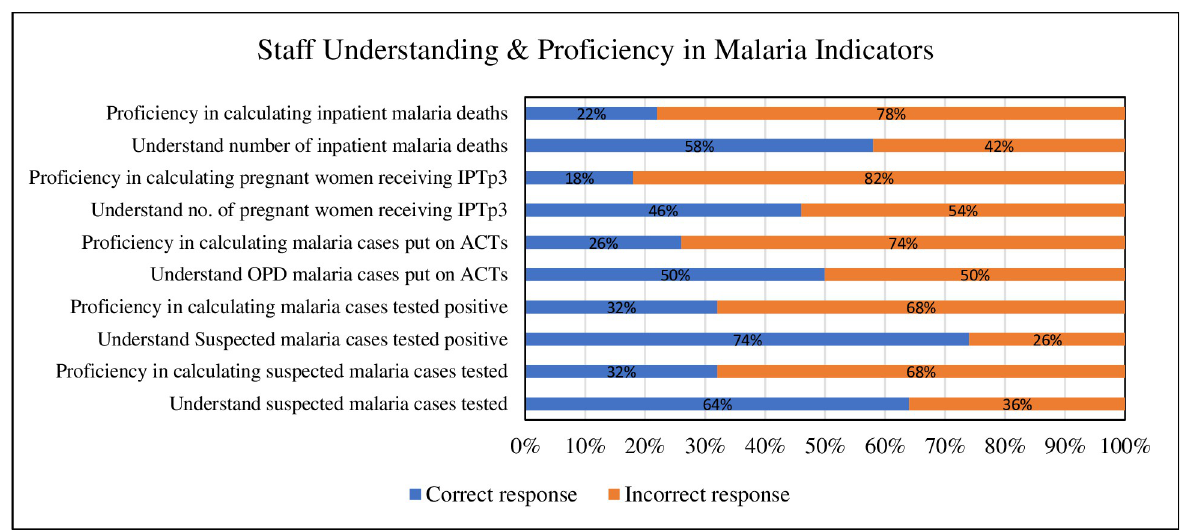
Fig 1. Staff understanding & proficiency in malaria indicators. Source: Survey, 2021.